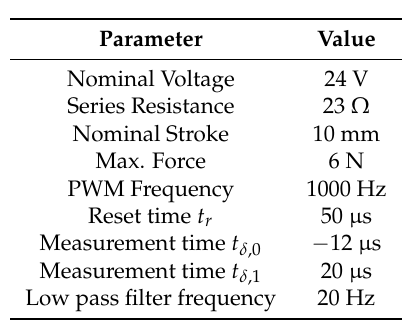
Table 1. Parameters of the solenoid actuator ITS-LZ 1949 from Red Magnetics as well as implementation parameters of the IDIM technique and the parallel resistor estimator.